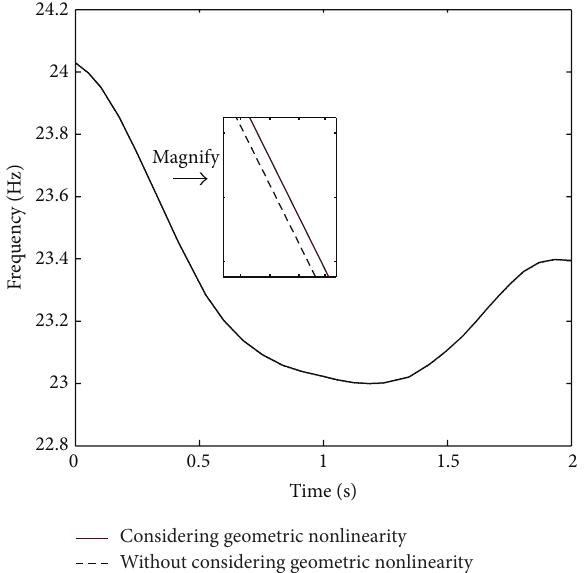
Figure 12: Base frequency of 4-UPS-UPU parallel